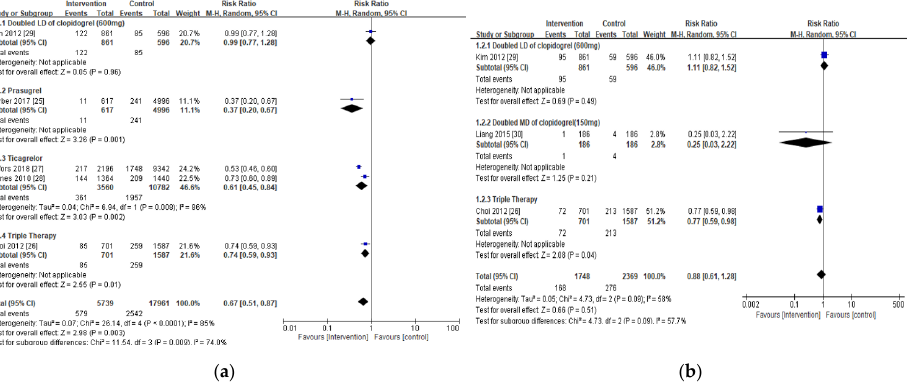
Figure 2. Forest plots of antiplatelet therapy effects on mortality in chronic kidney disease CKD patients: ( a ) all-cause mortality; ( b ) cardiac-related mortality. Blue indicates the risk ratio evaluated from each study and black indicates the overall risk ratio of the antiplatelet regimen.